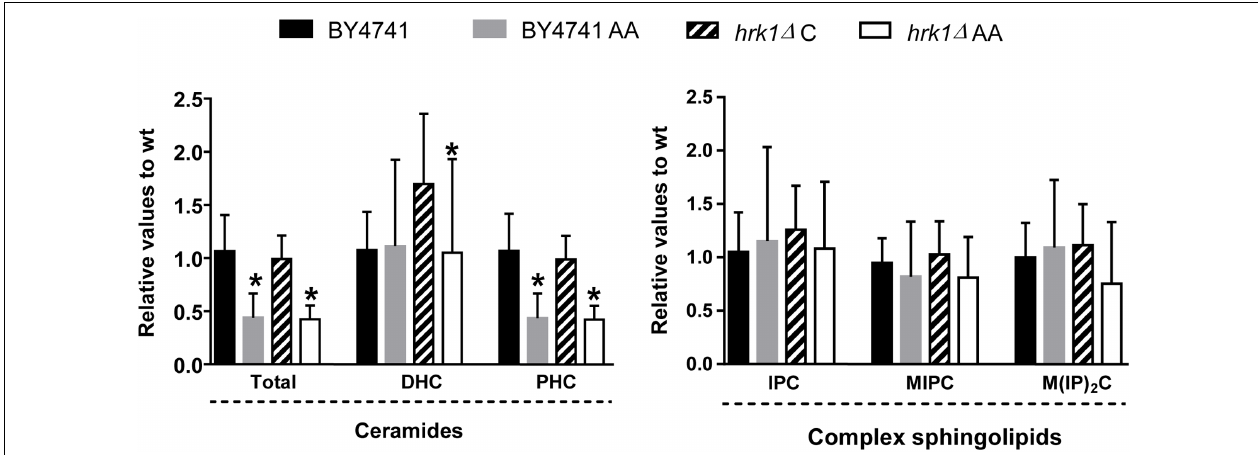
FIGURE 3 | Acetic acid leads to a decrease in the levels of total ceramides but has no effect on complex sphingolipid levels in BY4741 and hrk1 (cid:49) mutant strains. Yeast cells were grown in MM4 growth medium, supplemented (AA) or not with 50 mM acetic acid (at pH 4.0). Relative values were calculated as described in the section “Materials and Methods.” ∗ Significant differences, obtained by Tukey’s or Dunn’s test ( P < 0.05) compared with the respective control condition. The results were calculated from biological replicates ( n = 11 for complex sphingolipids and ceramides) and are given as the mean ± standard deviation. DHC, Dihydroceramide; PHC, Phytoceramide; IPC, Inositol phosphate ceramide; MIPC, Mannosyl-inositol phosphate-ceramide; M(IP) 2 C, Mannosyl-di-inositol